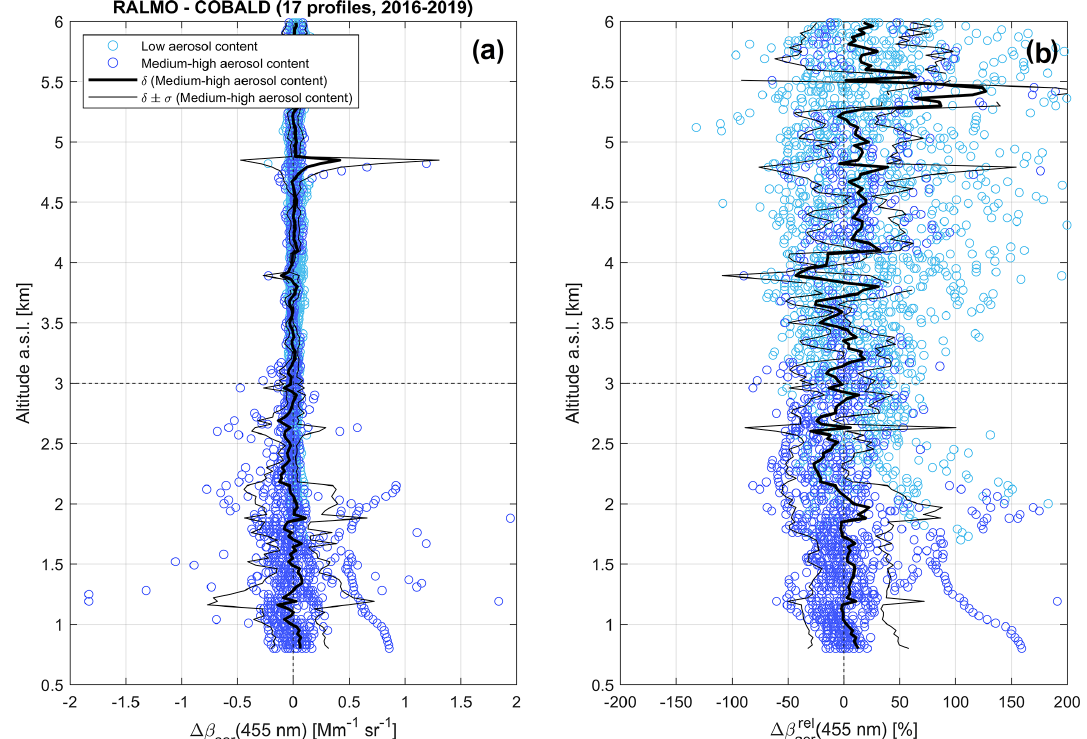
Figure 5. Statistical comparison of RALMO vs. COBALD: vertical profiles. Panel (a) : all medium-high-aerosol-content (dark-blue circles) and low-aerosol-content (light-blue circles) data points of the RALMO − COBALD aerosol backscatter coefficient difference ( (cid:49)β aer ) at 455nm as a function of altitude. Panel (b) : same as panel (a) , with (cid:49)β aer expressed in percent units (%) relative to the COBALD mea- surements (i.e., (cid:49)β rel aer ). Mean deviation ( δ ) and mean ± standard deviation ( δ ± σ ) profiles are shown in both panels by thick solid and thin dashed black lines, respectively. The 3km altitude level is highlighted by a thin dashed black